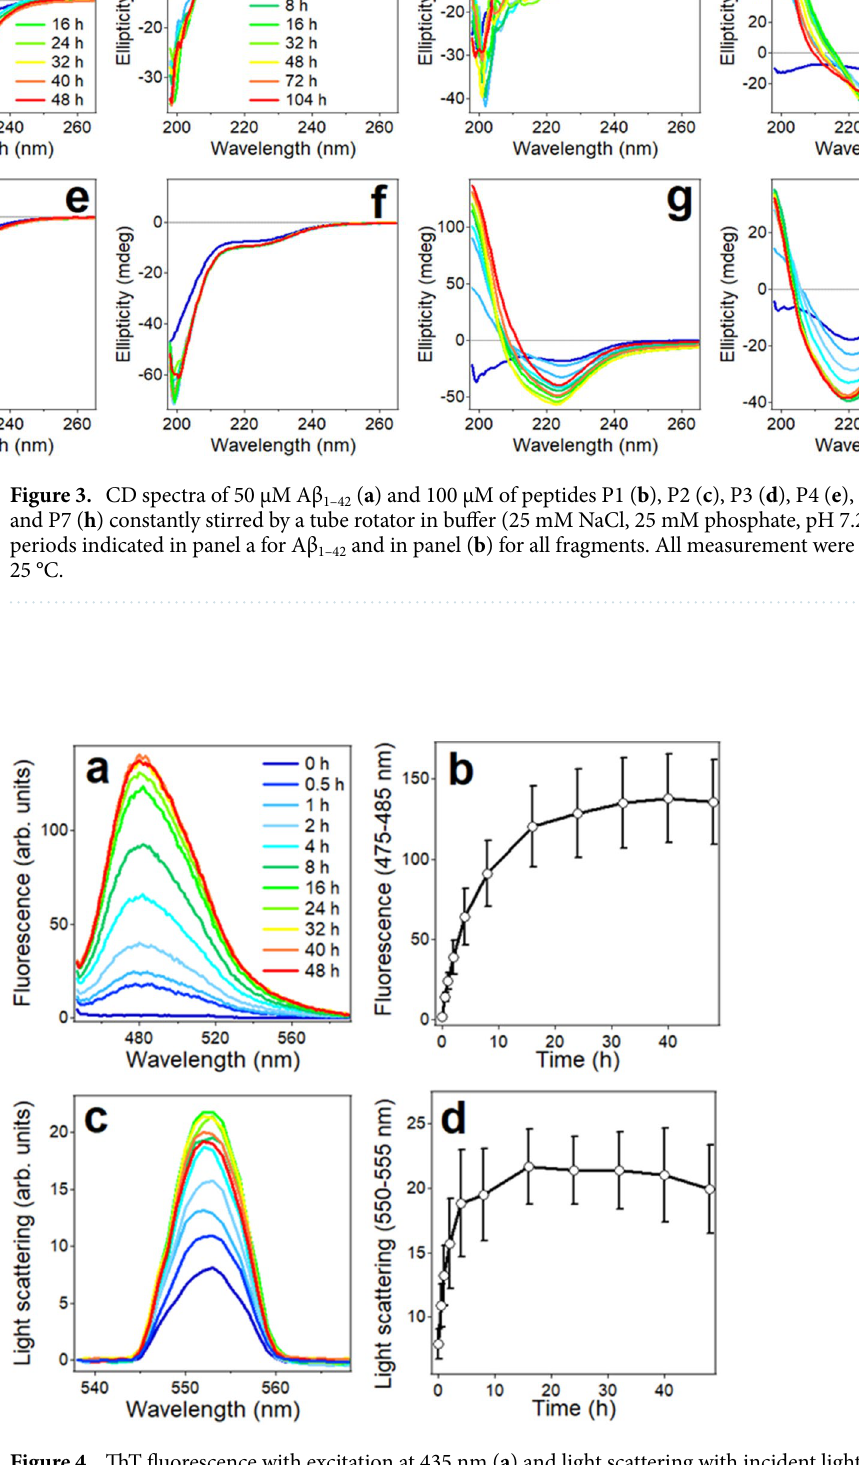
Figure 4. ThT fluorescence with excitation at 435 nm ( a ) and light scattering with incident light at 550 nm ( c ) of 35 μM Aβ 1–42 in buffer (25 mM NaCl, 25 mM Na,K-phosphate, pH 7.2) stirred by a tube rotator for time periods indicated in panel a. Time dependence of ThT fluorescence averaged between 475 and 485 nm and of light scattering averaged between 550 and 555 nm are presented in panels ( b ) and ( d ), respectively, which represent average data and standard deviations from three independent